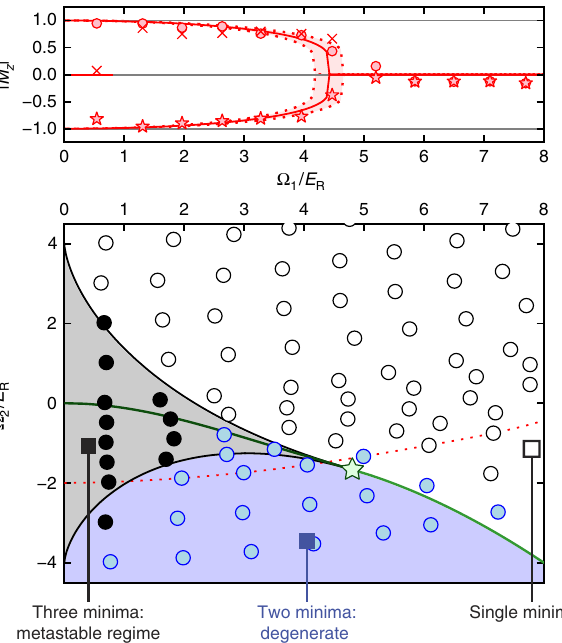
Three minima: Single minimumTwo minima: metastable regime degenerate Figure 4 | Metastable states. Top, Measured magnetization plotted along with theory. The system was prepared at the desired O 2 ¼ (cid:4) 2 E R ; O 1 ( t ) was then increased to its displayed final value; during this ramp O 2 also changed, and the system followed the curved trajectory in the bottom panel. Each displayed data point is an average of up to 10 measurements, and the coloured region reflects the uncertainty in theory resulting from our E 5% systematic uncertainty in O 1 . Circles/crosses/stars represent data starting in m F ¼ þ 1, 0, and (cid:4) 1 respectively. Bottom, state diagram: theory and experiment. Blue: two states; black: three states; white: one state. Coloured areas denote calculated regions where the colour-coded number of stable/metastable states are expected. Symbols are the outcome of experiment. Each displayed data point is an average of up to 20